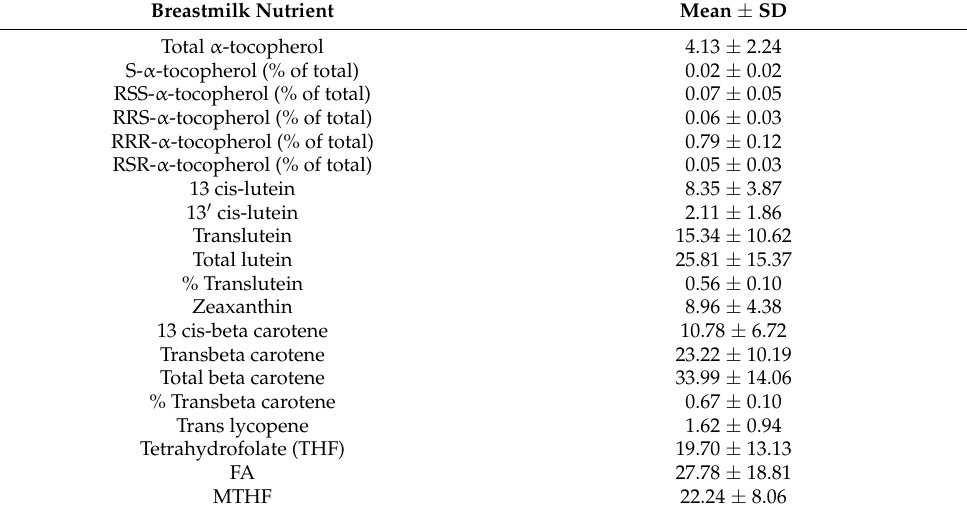
Table A6. Distribution of breastmilk nutrients within